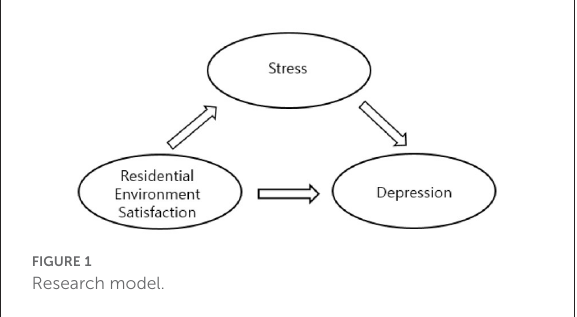
FIGURE1 Research